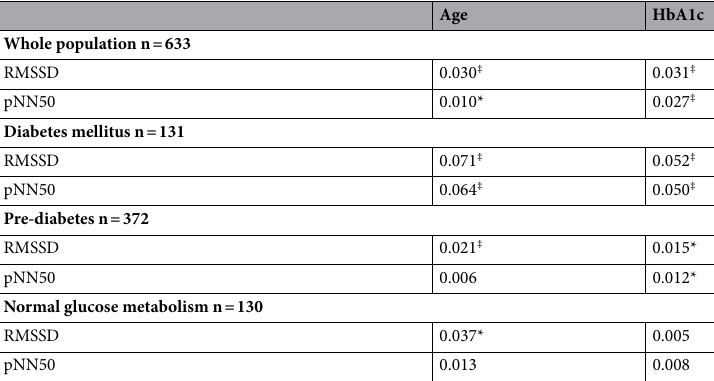
Table 4. Backward elimination model evaluating variables best associated with parasympathetic components of heart rate variability (RMSSD and pNN50). Results of the backward elimination selection regression presented as partial R 2 for the variables. Only age, sex, and HbA1c stayed significant. Other variables; LGI markers, glucose metabolism variables (FPG, HOMA-IR, and insulin), triglycerides, creatinine, sex, BMI, smoking habits, and physical activity remained insignificant in all models except for creatinine in the subgroup of normal glucose metabolism. RMSSD Root mean square of successive normal-normal interval differences, pNN50 Proportion of NN intervals which differs by more than 50 ms. Logarithmic values of RMSSD, pNN50. Physical activity was dichotomized in two groups: Group 1 included participants with an almost sedentary lifestyle or only light physical activity of 2–4 h per week. Group 2 included participants with moderate to high levels of physical activity or training of at least 4 h per week. *p < 0.05. ‡ p <